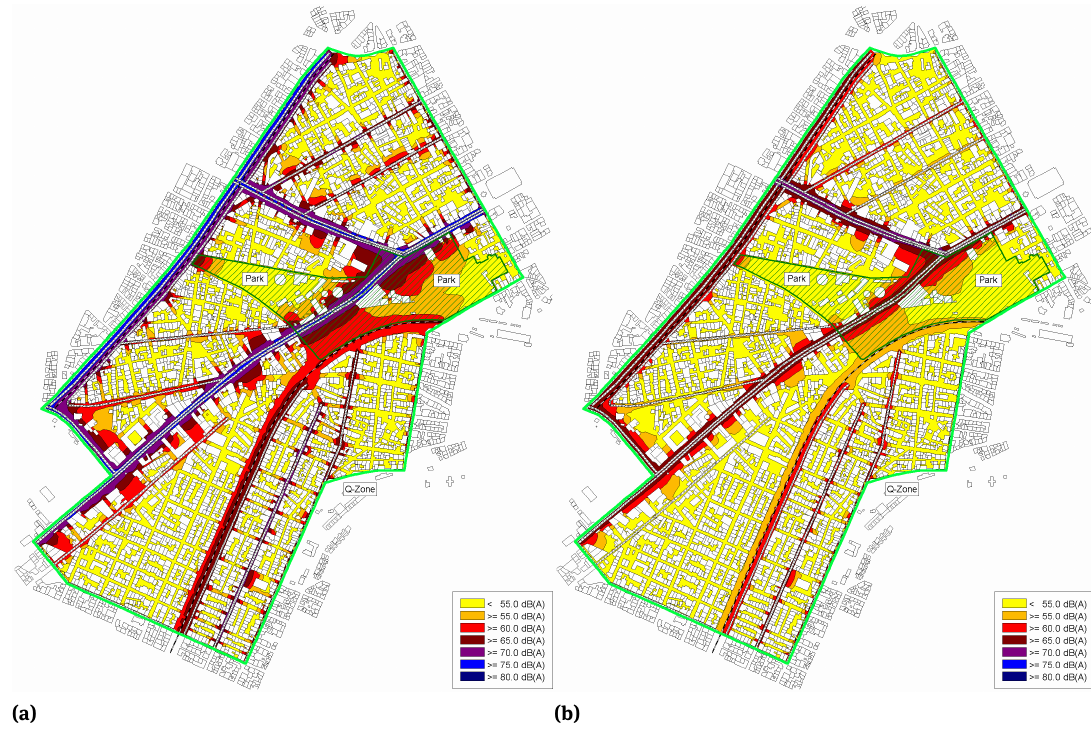
Figure 12: Scenario S07 - L